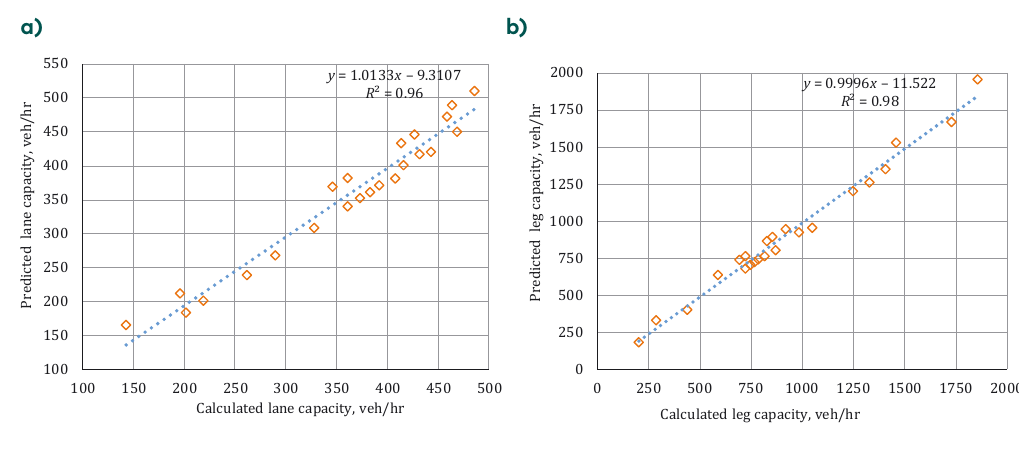
Figure 7. The relation between the calculated ( c c ) and predicted ( c p ) capacity values for intersection lanes and legs